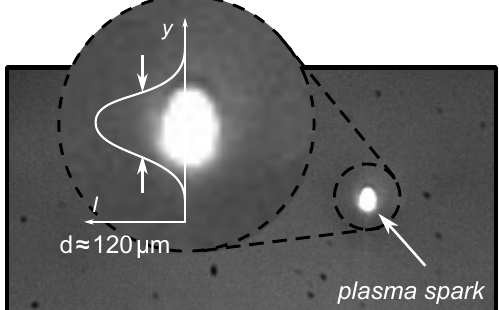
Figure 7. Example of the measurement of the plasma size d ≈